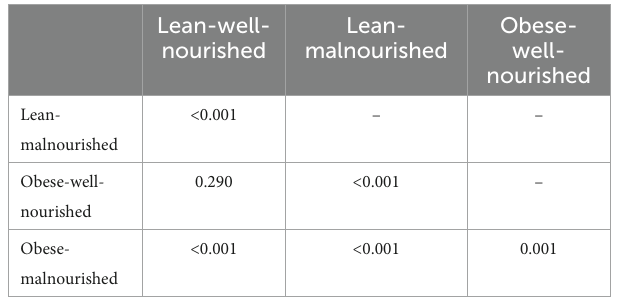
TABLE 3 Pairwise comparisons of different groups in the Kaplan–Meier survival analysis.